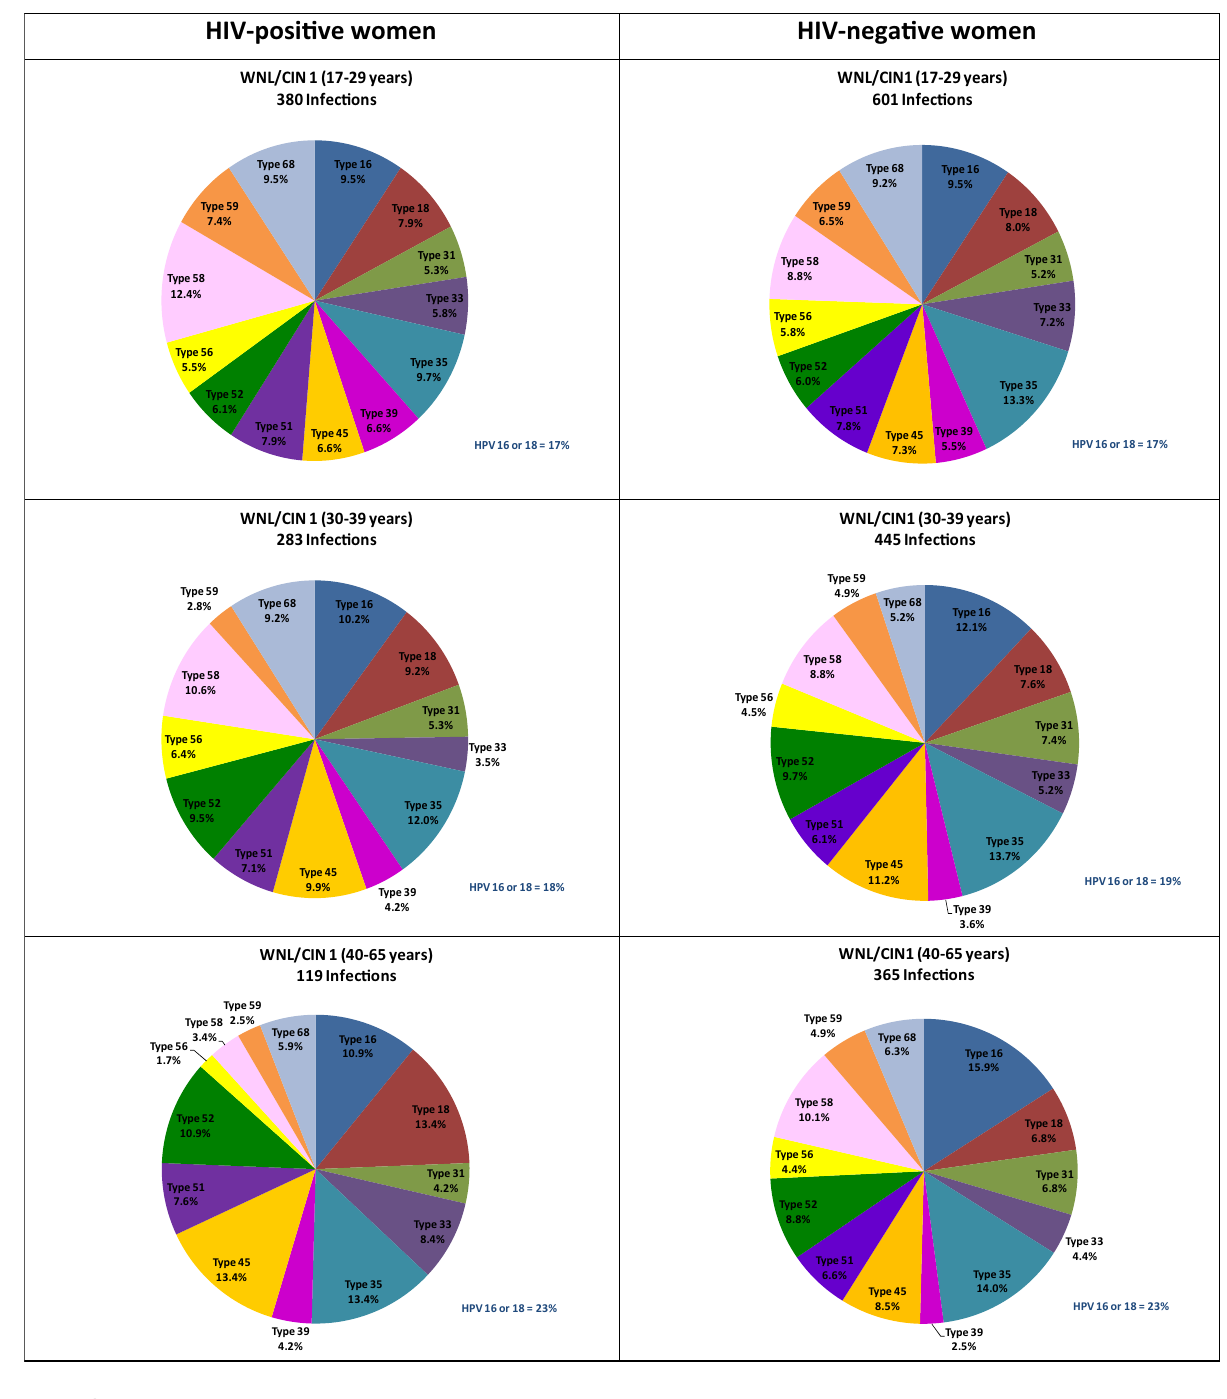
intraepithelial neoplasia grade 1 only . Note:WNL, within normal limits; CIN, cervical intraepithelial neoplasia; HR, high-risk; HPV, human papillomavirus. See Supplementary Material for